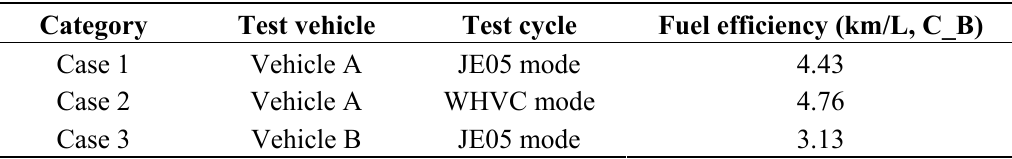
Table 6. Fuel efficiency test results.